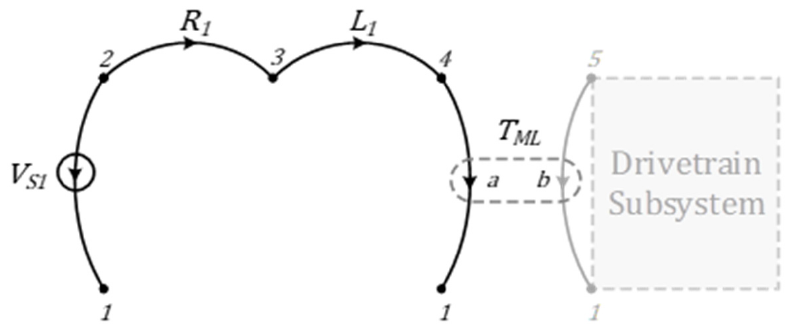
Figure 4. LG model and the normal tree of the Husky robot electrical subsystem.